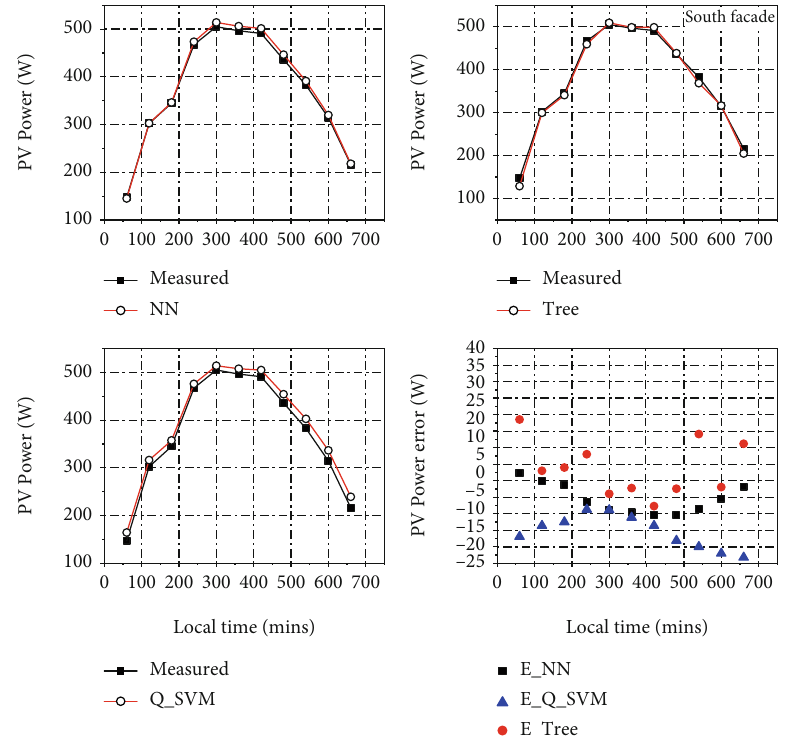
Figure 8: PV power prediction and error of the NN-QSVM-Tree models for the south facade.